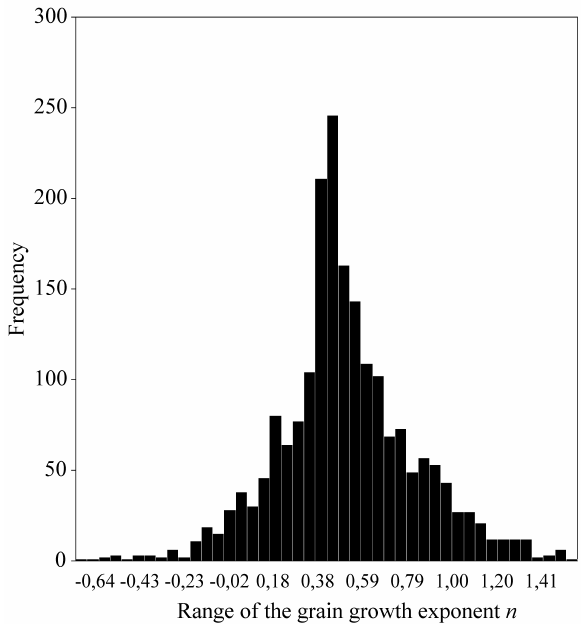
Figure 8. Histogram of the local slopes.